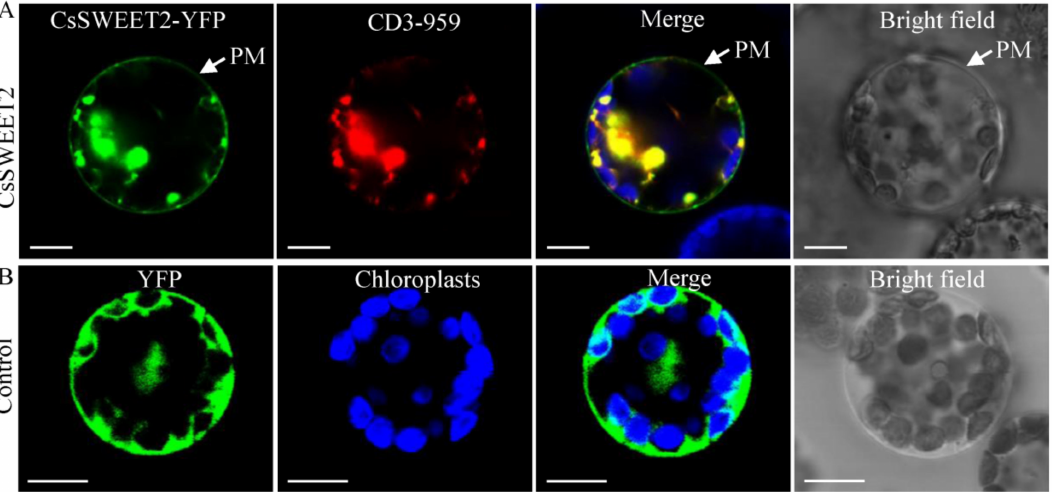
Figure 3. Subcellular localization of the CsSWEET2-YFP fusion protein in Arabidopsis mesophyll protoplasts. An mCherry-labelled marker (CD3-959) was used to mark the endoplasmic reticu- lum position. The arrows in ( A ) point to plasma membranes. An empty vector expressing un- targeted YFP was used as a control ( B ). The green signals indicate YFP, whereas the red signals indicate the endoplasmic reticulum marker. In addition, the blue signals indicate the chlorophyll auto fluorescence. Their merged images and bright field images are also presented. PM, plasma membrane. Scale bars = 10 µ